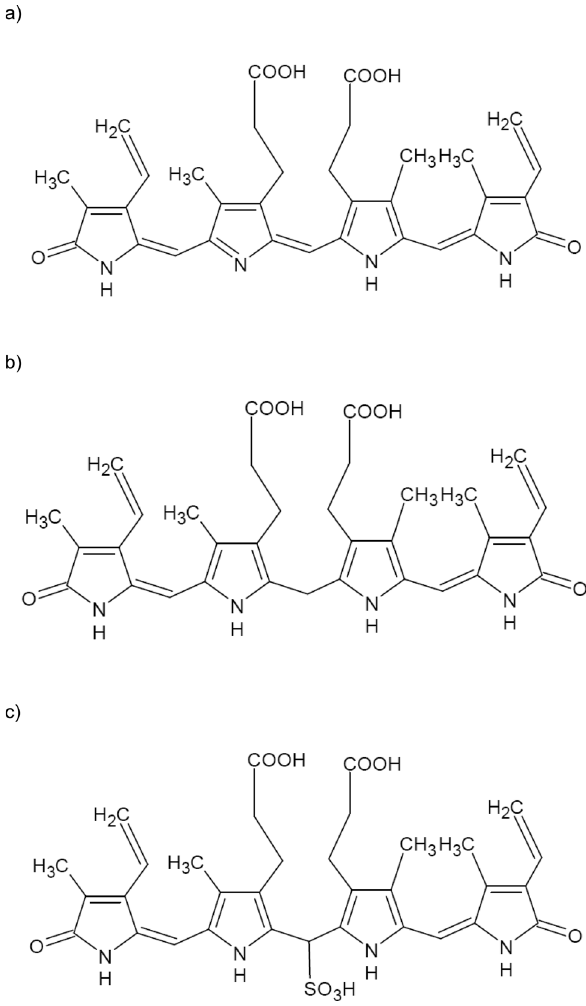
Figure 1. Structures of ( a ) biliverdin, ( b ) unconjugated bilirubin, and ( c ) bilirubin-10-sulfonate